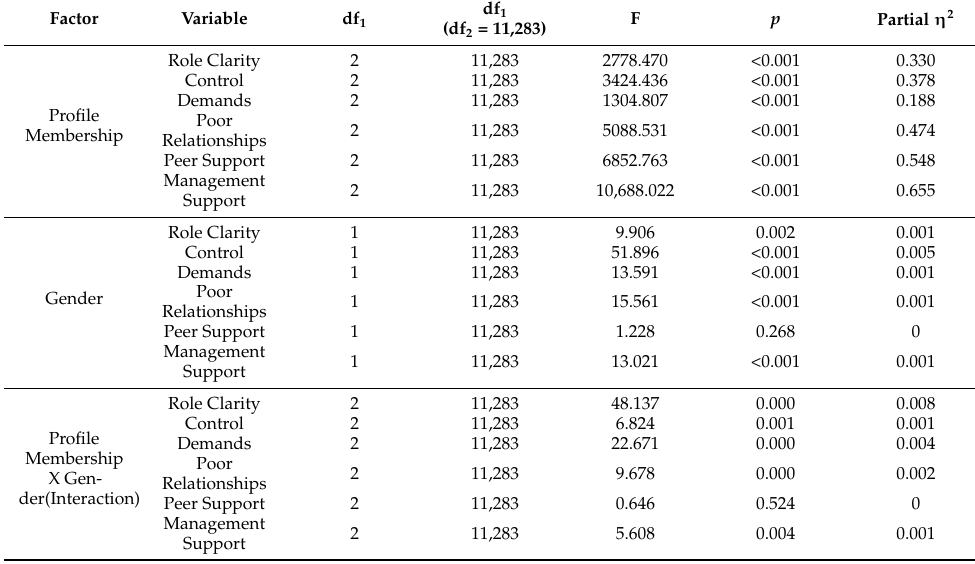
Table 4. Principal Effects of the Two-Way Factorial